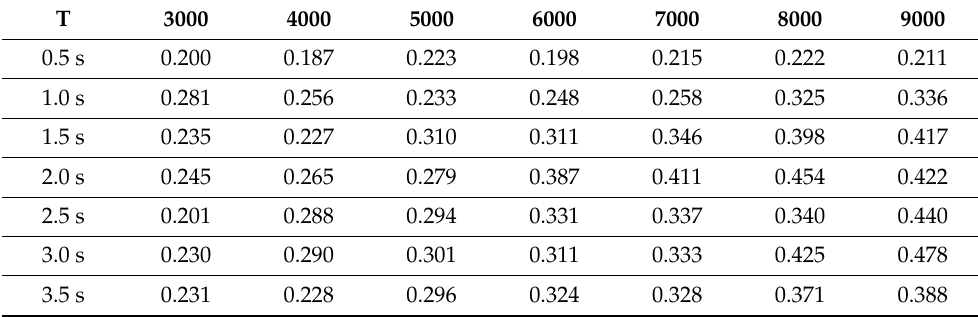
T = Transaction Collection